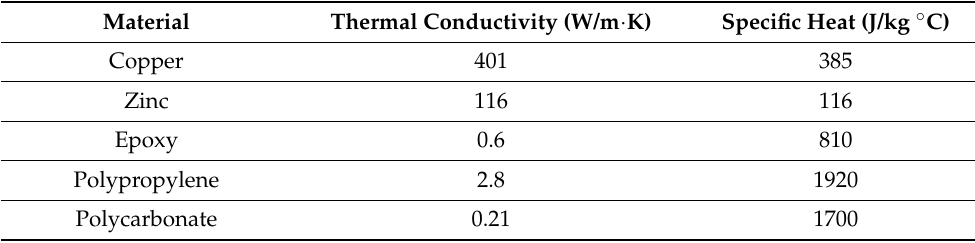
Table 2. Thermal characteristics of parts.